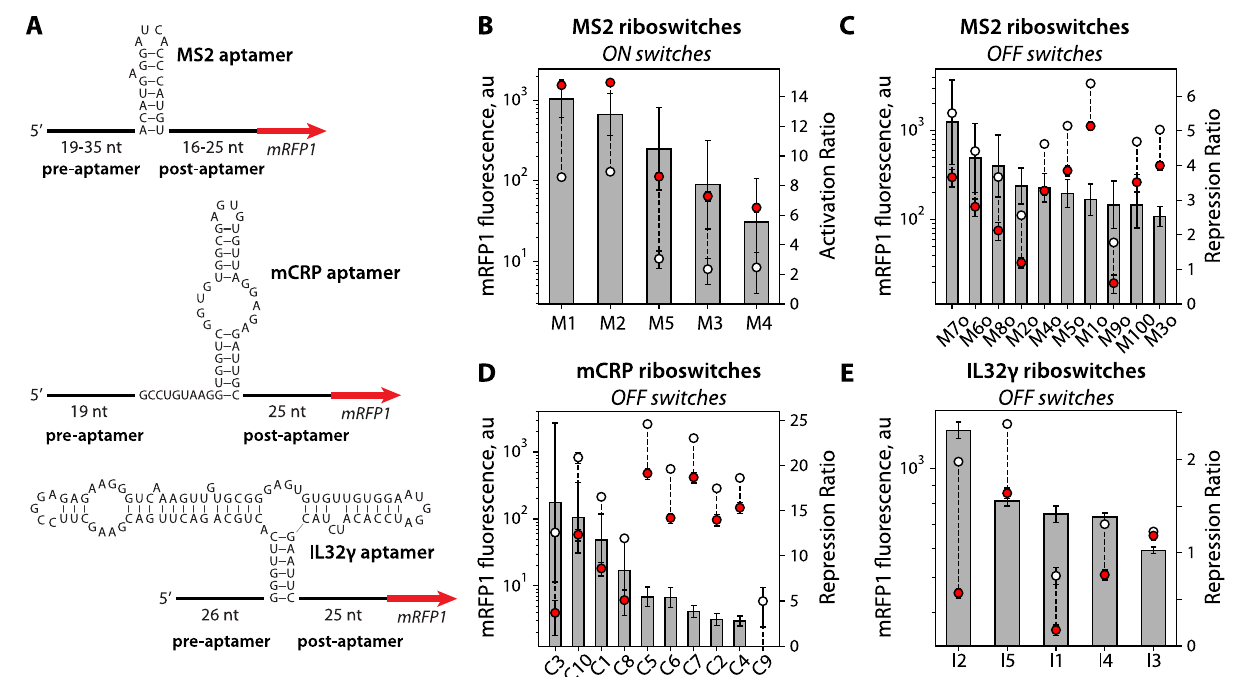
Fig. 2 | Design and function of protein-sensing riboswitches. A Riboswitch sequencesdesignedfordetectingtheMS2,mCRP,andIL32 γ proteinligands. B MS2 ONswitches,inducedwith8nMMS2CDS. C CharacterizationofMS2OFFswitches, induced with 16nM MS2 CDS. D Characterization of mCRP OFF switches, induced with 1.25 μ M of mCRP. E IL32 γ OFF switches, induced with 780nM IL32 γ . Gray bars